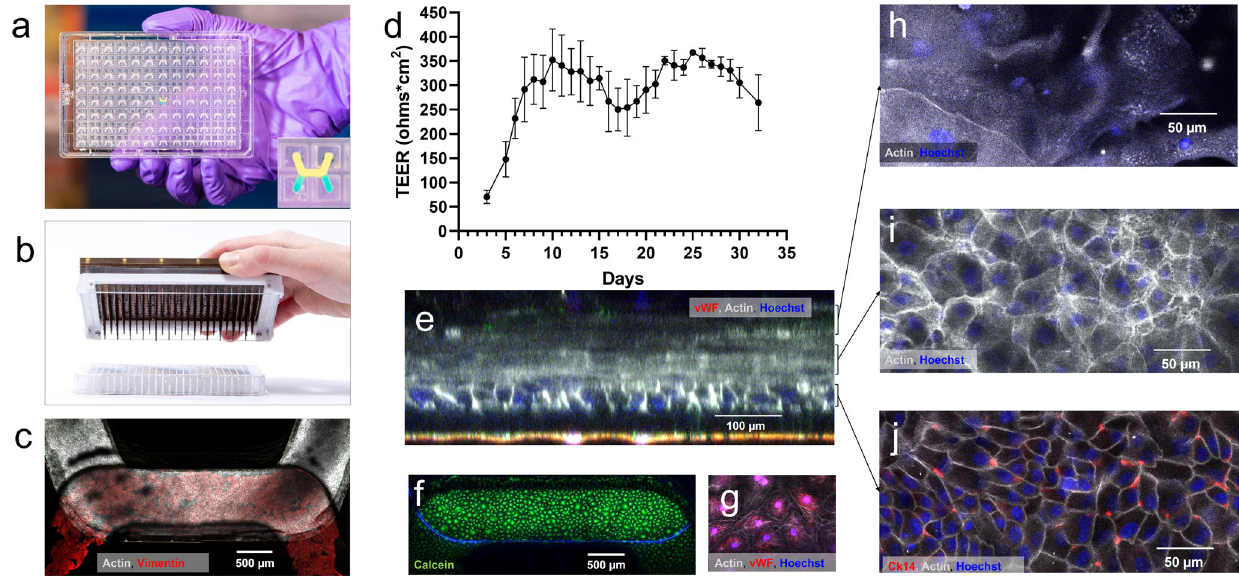
Fig. 1 A triculture model of human gingival tissue, comprised of human gingival fi broblasts (hGFs), human oral keratinocytes (hOKs), and human microvascular cells (hMVECs) have been cultured in PREDICT96 for 1 month under recirculating fl uid fl ow. a Draper ’ s high-throughput micro fl uidic culture platform contained 96 micro fl uidic devices with a top and bottom channel (inset) separated by a porous membrane (1 µ m pore size, 1e6 porosity). b The micro fl uidic-based pump exists in the lid of the plate and delivers independent fl uid fl ow to the top and bottom channels of each micro fl uidic device. c A maximum intensity projection of the top channel of a single PREDICT96 device showed a con fl uent layer of hOKs after 32 days of culture. d Mean TEER measurements from three separate experiments and up to 288 replicates per day indicated a general trend of barrier formation over the experimental duration. The tissue barrier increased over the fi rst 10 days of culture as layers proliferated and junctions formed, reaching a plateau sustained between 250 – 360 Ohms cm 2 for the following ~21 days. Error bars represent standard deviation. e A confocal orthogonal view of the MOUTH tissue showed >100 µ m thick hOK tissue on the top side of the membrane. f Calcein live stain of hMVEC layer at day 32 demonstrates a robust endothelial layer can be maintained through extensive culture with g von Willebrand factor (red), indicating vascular-speci fi c staining on the bottom side of the membrane. h – j Changes in tissue morphology and structure could be seen at different z-planes of the tissue, including h a layer with visible granules in the upper z- plane, i a distinct actin structure in the middle z-plane, and j a basal proliferative layer of